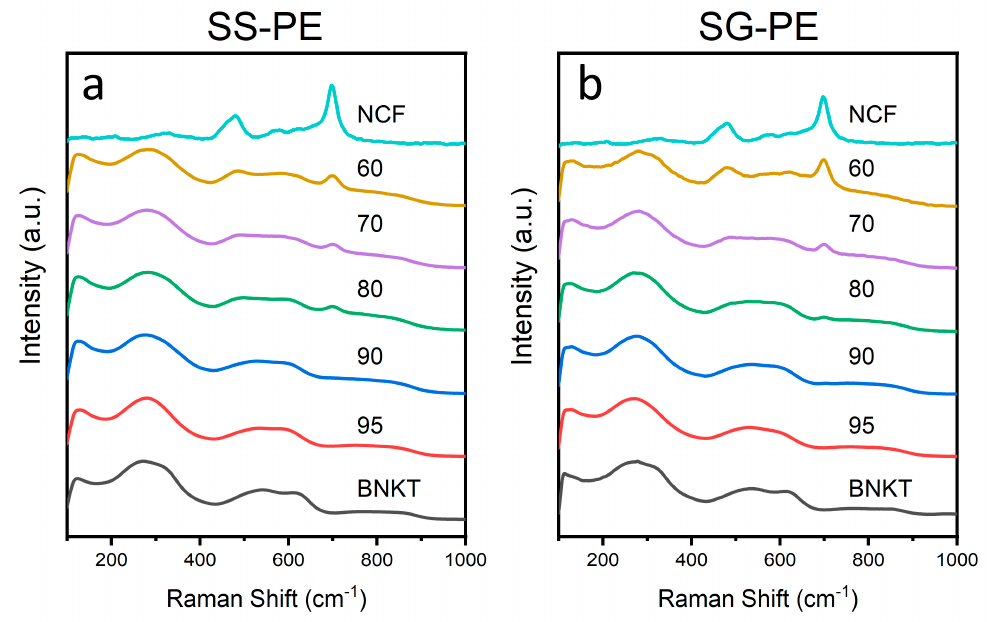
in the Raman spectra are identified. The bands located at 700, 650, and 620 cm − 1 , associated with the symmetric stretch of oxygen atoms along the (Fe/M)-O bond, can be assigned to Fe-O, Ni-O, and Co-O cations, respectively. The band at 485 cm − 1 is associated with the anti-symmetric stretch of oxygen atoms along the (Fe/M)-O bond. The bands at 327 and 570 cm − 1 are symmetric and antisymmetric bending modes of oxygen concerning Fe(M), respectively, and finally, the band at 213 cm − 1 is assigned to the translational movement of tetrahedron MO 4 [48].